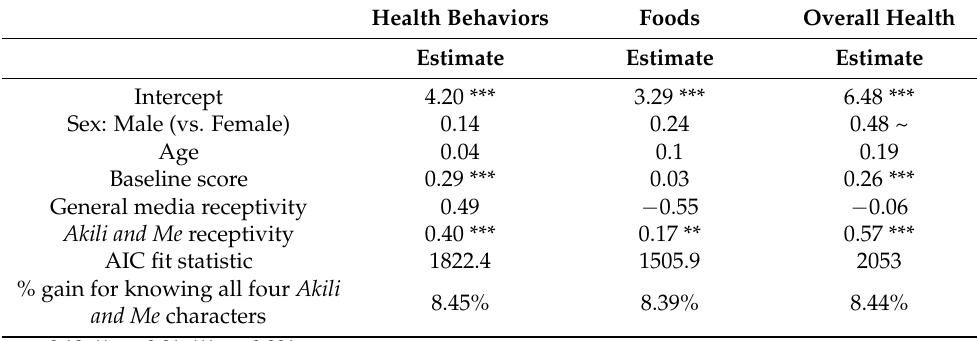
Figure 3. Baseline and post-intervention scores for socio-emotional and health scores. Means and 95% confidence limits for means (bars) calculated accounting for clustering by school. * Indicates significant difference at α = 0.05 in bivariate multi-level model analysis of baseline and post-intervention scores in each category and sub-category. Table 3. Models predicting the socio ‐ emotional outcomes, exploring Akili and Me receptivity. Table 4. Models predicting the health outcomes, exploring Akili and Me receptivity.